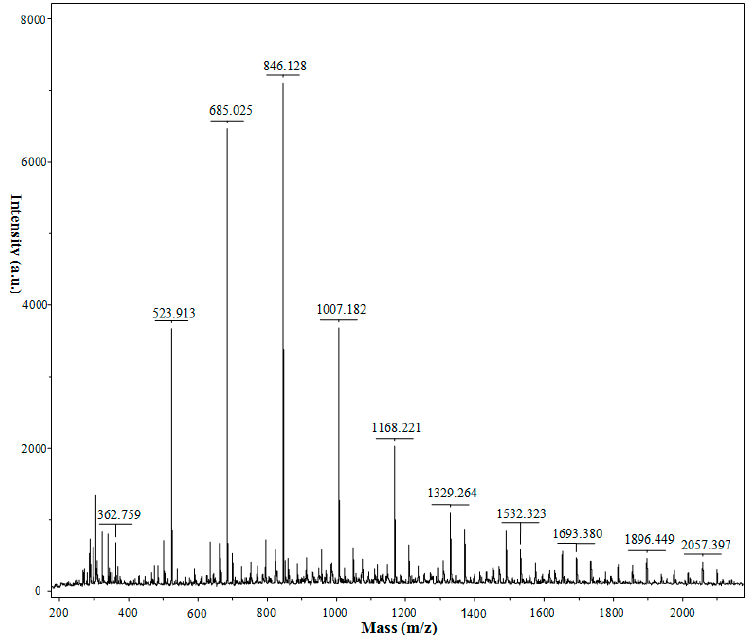
Figure 4. The matrix-assisted laser desorption/ionization time-of-flight mass spectrometry ( MALDI-TOF-MS) of chitooligosaccharides technical concentrate.